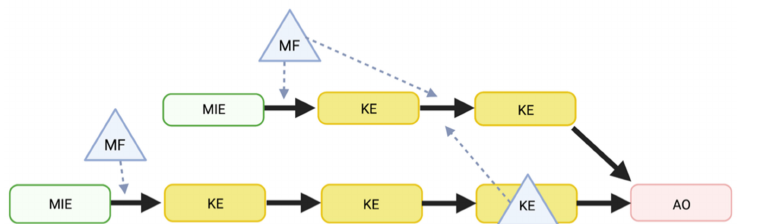
Figure 4. Visualization of MFs within an AOP network. Individual MFs (blue triangle) might have an influence (dotted line) on one or several KERs within an AOP or within a network. In addition, a KE (blue triangle within the rectangle) can act as a MF for KER(s) in other AOP(s). Diagram adapted from US EPA. Created with